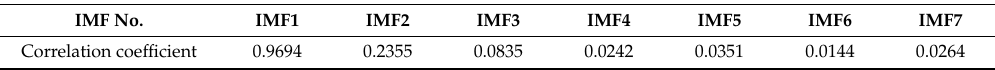
Table 5. Correlation coefficients of each experimental IMF.